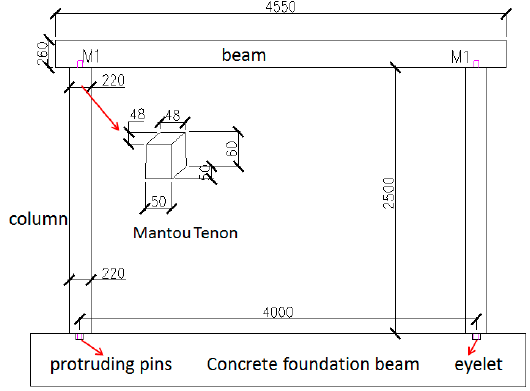
Figure 4. Details of the timber frame.